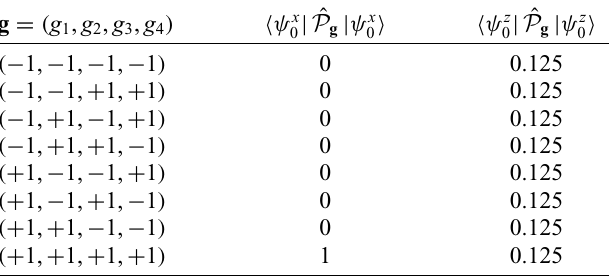
TABLE I. The accessible superselection sectors g and the expectation values of their projectors states of Fig. 2. The gauge-invariant initial state | ψ x within a single superselection sector g j = + 1 for all j , while the gauge-noninvariant initial state | ψ z superposition over all accessible superselection sectors.